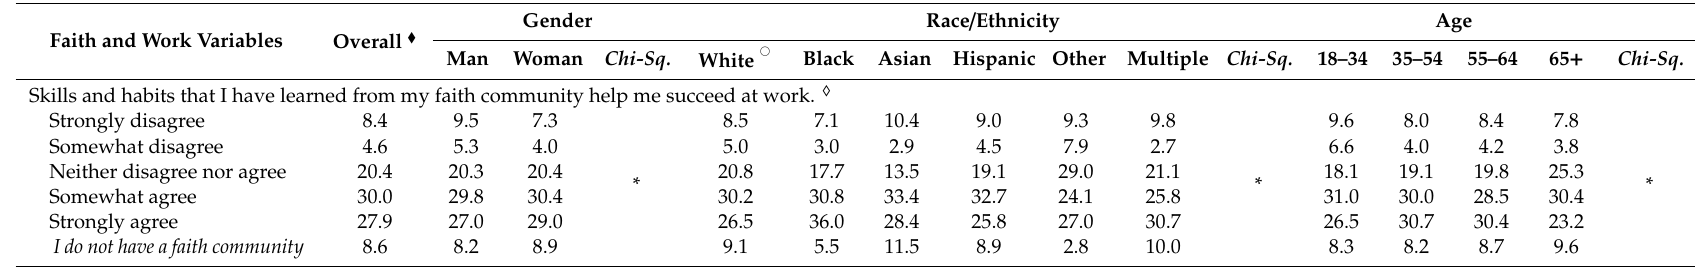
Table A2. Faith and Work Survey Questions By Gender, Race / Ethnicity, and Age Among a Sample of Practicing Christians ( n = 7305). Gender Race / Ethnicity Age Faith and Work Variables Overall (cid:7) Man Woman Chi-Sq.